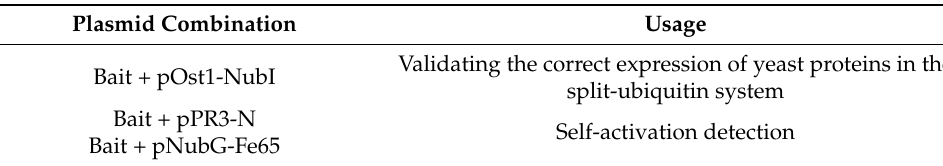
Table 1. The combination of plasmid and